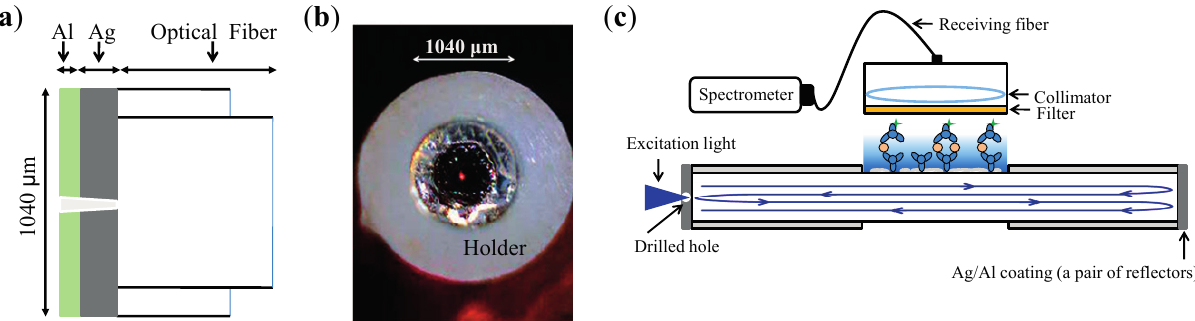
Figure 1. ( a ) Sensor’s end-face coated with silver (Ag; 500 nm) and aluminum (Al; 100 nm) to form a reflector; ( b ) 30 µm hole (marked by a red laser-pointer light), at the center of